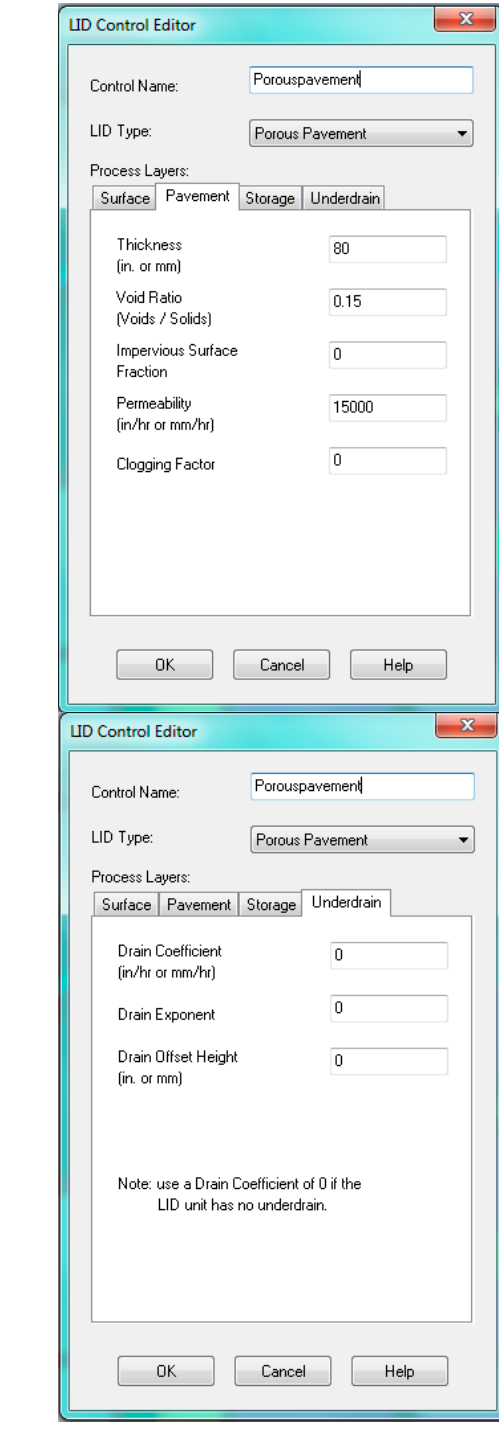
Figure A3. Representation of porous pavement in SWMM and design parameters used.